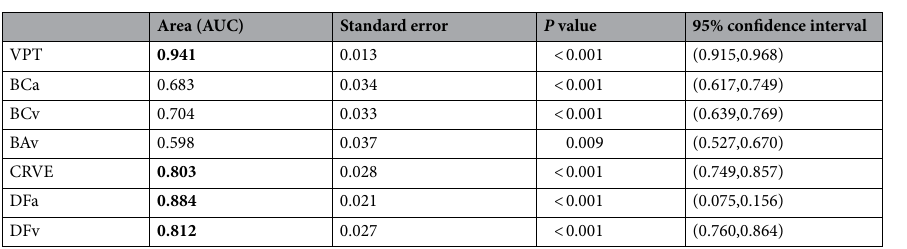
Table 2. AUC comparison between VPT and retinal vessel parameters. Bold values indicate area under the curve greater than 0.8. AUC area under the curve, VPT Vibration perception threshold, BCa Branching coefficient arterioles, BCv Branching coefficient veins, BAv Branching angle veins, CRVE Central retinal vein equivalent, DFa Fractal dimension arterioles, DFv Fractal dimension veins.